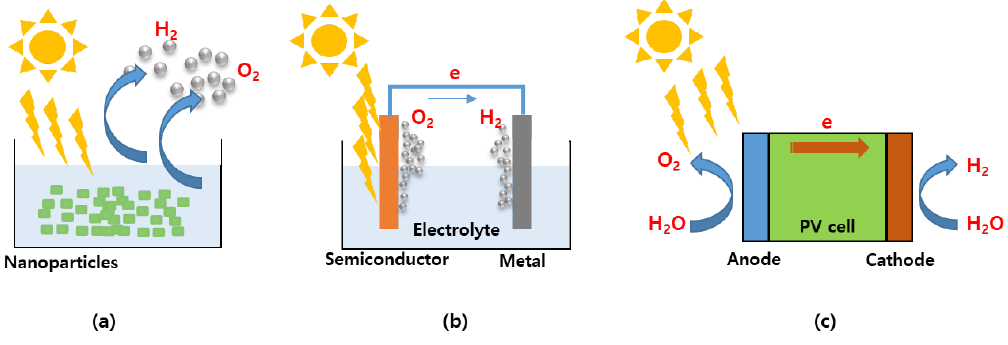
Figure 1. The solutions for solar hydrogen via water splitting. ( a ) Particulate photocatalytic (PC) water splitting system, ( b ) Photoelectrochemical (PEC) water splitting system and ( c ) Photovoltaic–